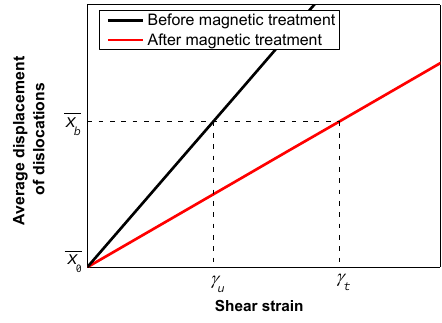
Figure 11. Relationship between average displacement of dislocations 𝑥̅ and shear strain γ.